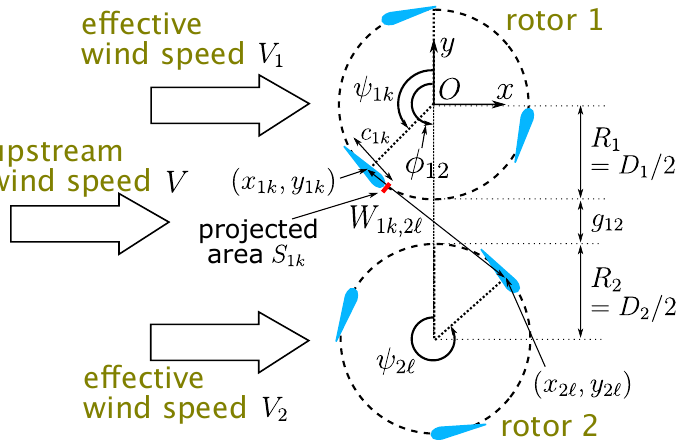
Figure 2. Definitions of